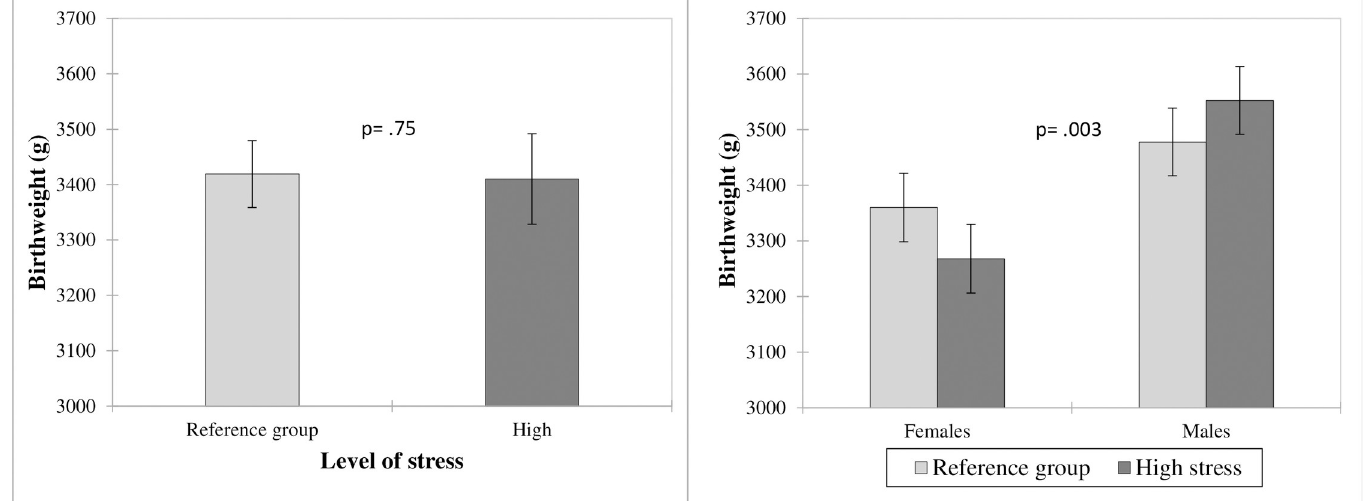
Fig 2. Neonate birthweight as a function of maternal psychological stress during pregnancy and newborn sex. Results presented as Least Square (LS) means with CI 95% ; variables included in the model: maternal age, pre-pregnancy BMI, weight gain during pregnancy, parity, presence of GDM and HDP, gestational age at delivery, smoking status, level of stress, sex of the newborn and ‘level of stress � sex of the newborn’ interaction.